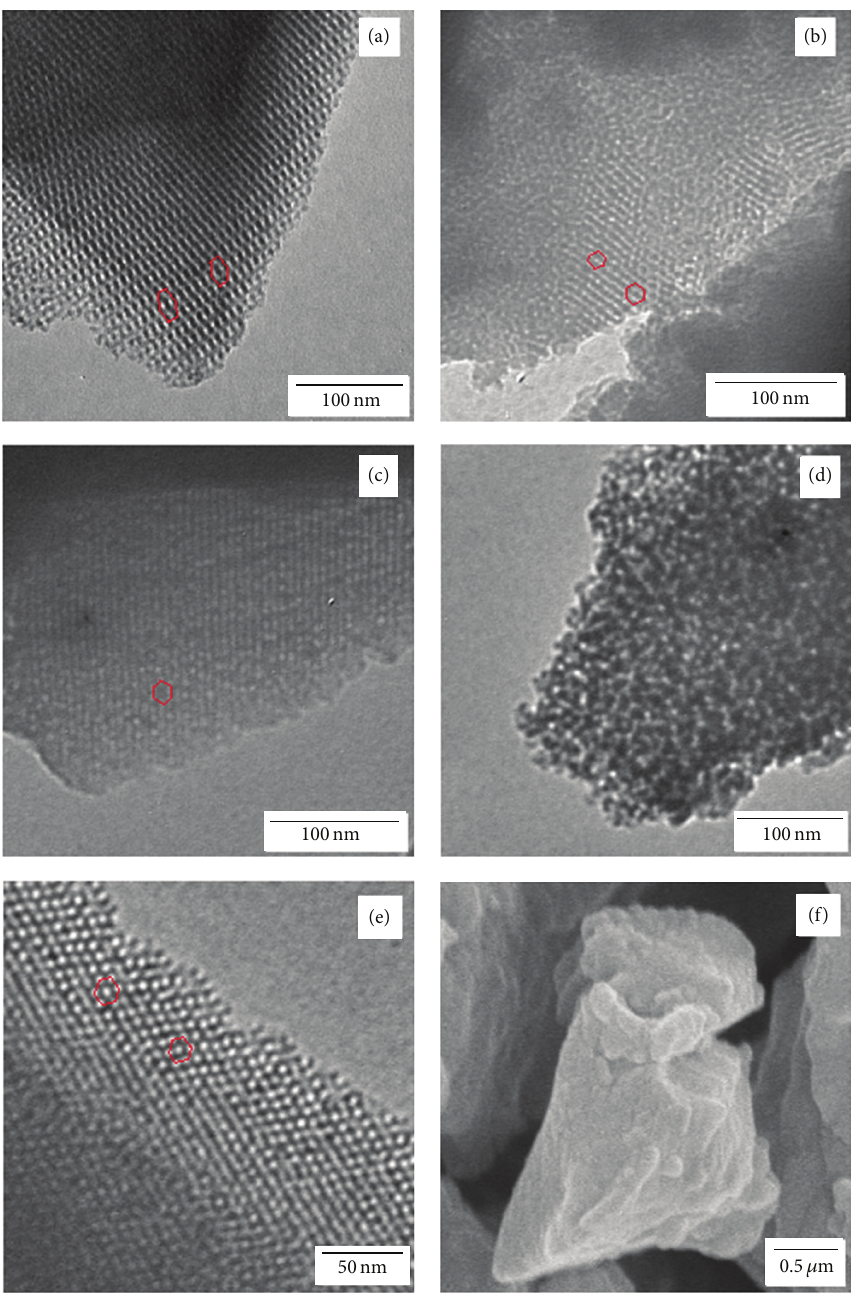
Figure 2: (a) TEM image of BG-La-1, (b) TEM image of BG-La-2, (c) TEM image of BG-La-3, (d) TEM image of BG-La-4, (e) TEM image of BG-La-5, and (f) SEM image of BG-La-2.